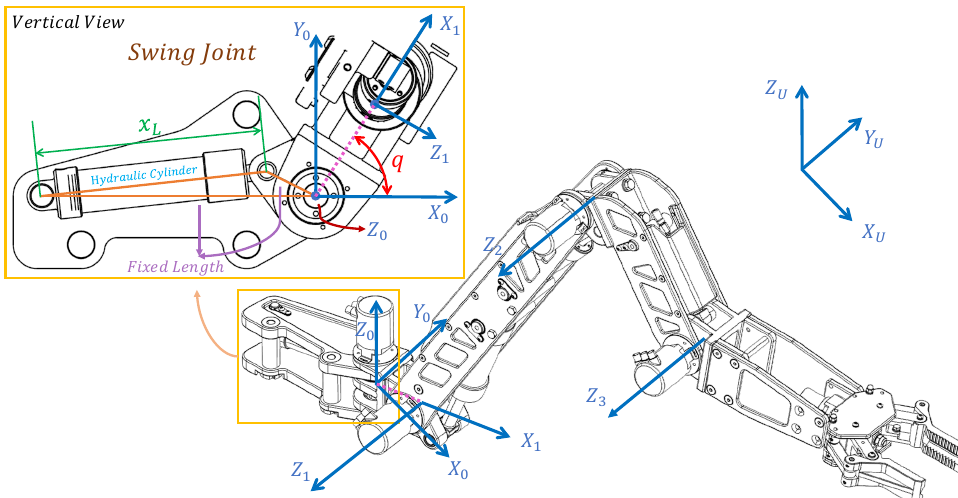
Figure 1. Schematic diagram of the mechanical arm